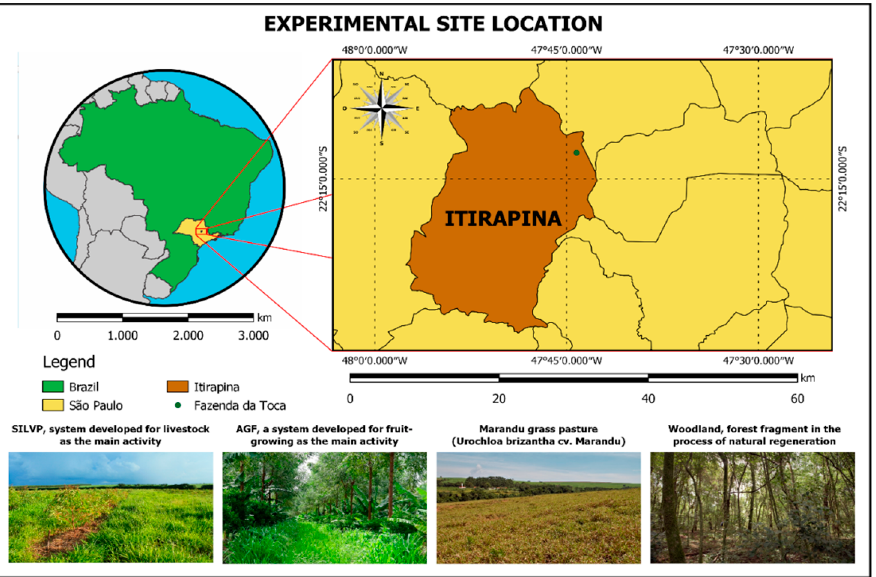
Figure 1. Location of the municipality of Itirapina, in the state of São Paulo, highlighting the study area at Fazenda da Toca and photos of the implemented SAFs. (Source of images: Fazenda da Toca Farm archives).